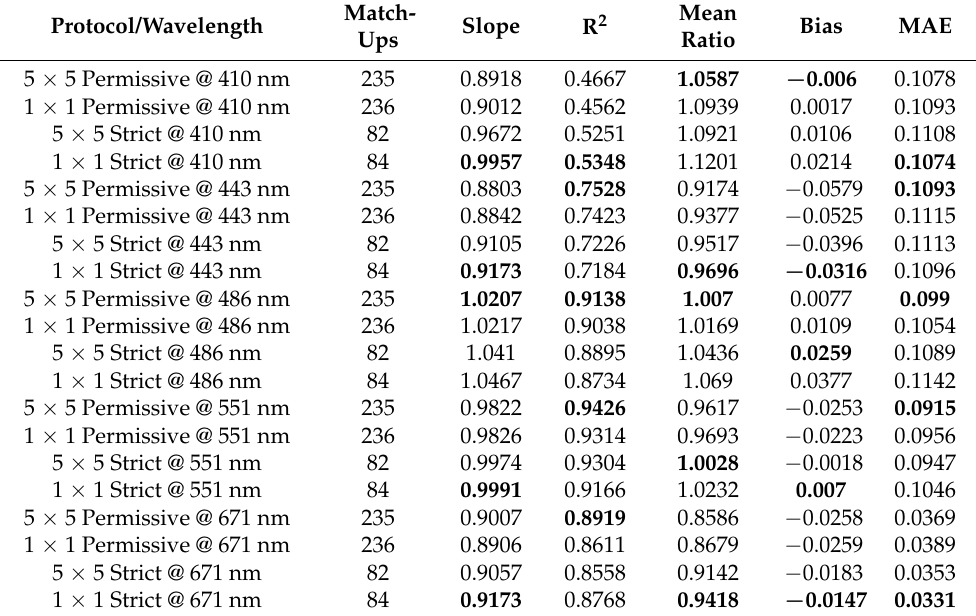
Table 2. Strict and permissive results at WaveCIS. June 2014–May 2019 data. Values closest to one in bold, for slope, R 2 , and mean ratio. Lowest values in bold for bias and mean absolute error.